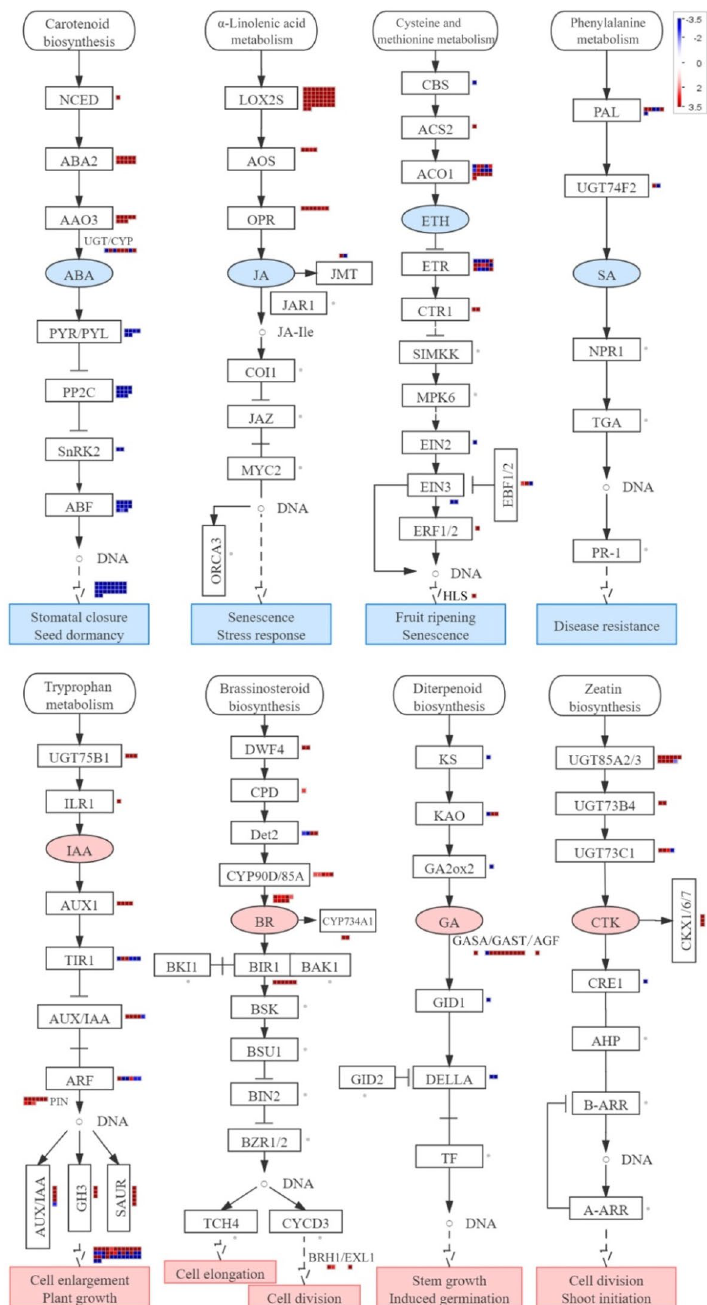
Figure 3. Schematic of DEGs involved in plant hormone pathways 34 . Key enzymes and proteins are presented as their names. Red dots indicate up-regulated genes; blue dots indicate down-regulated